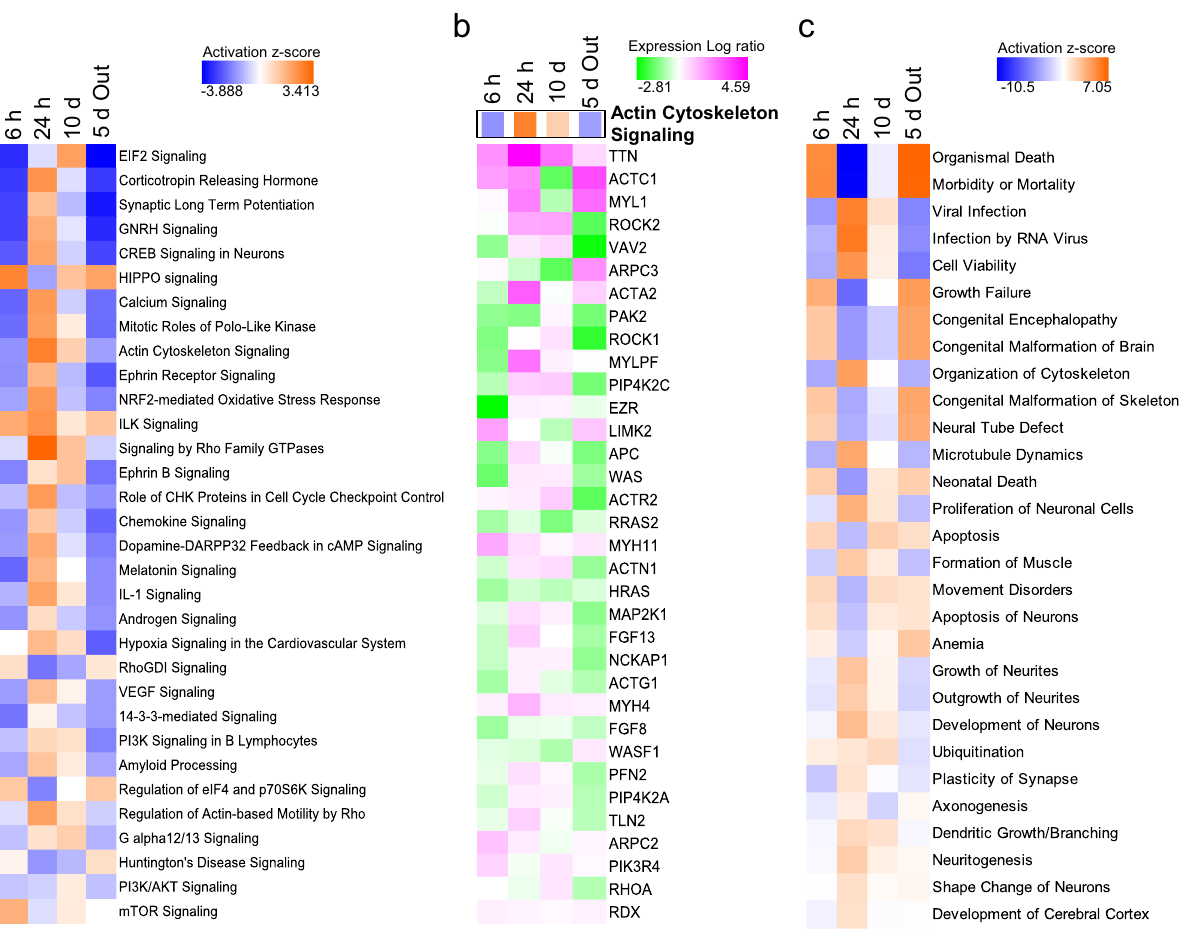
Figure 3. Ingenuity pathway analysis (IPA) of the expressed genes induced in the Xenopus laevis whole brain by the threat of predation. Heat map of the altered signal transduction pathways in each treatment group. The number of expressed genes after 6 h (6 h of exposure to a predation threat) were divided by those of the Cont (no exposure to a predation threat) and used to predict the altered signal transduction pathways. 24 h (24 h exposure to a predation threat), 10 days (10 days exposure to a predation threat), and 5 days out (5 days exposure to a predation threat, followed by five days of no threat) also indicate the altered signal transduction pathways compared with that of the Cont, respectively. (a) Heat map of the genes expressed in the actin cytoskeleton signaling. Genes involved in actin cytoskeleton signaling were obtained from the IPA, and the levels of expressed genes in each treatment group were compared with that of the Cont. Panels surrounded by the black rectangles, indicate the degree of actin cytoskeleton signaling from (a) . The gene symbols and corresponding Entrez Gene Names in (b) are given in Supplementary Table 4. (b) Disease and function predicted by the analysis of the total signal transduction pathways. The prediction was performed by IPA using the expressed genes compared with those of the control. The displayed diseases and functions are restricted to the top 29